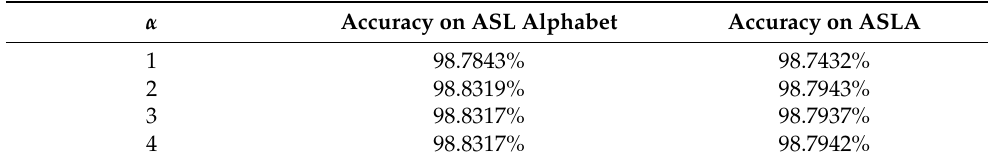
Table 8. Accuracies by α in ARS-MA